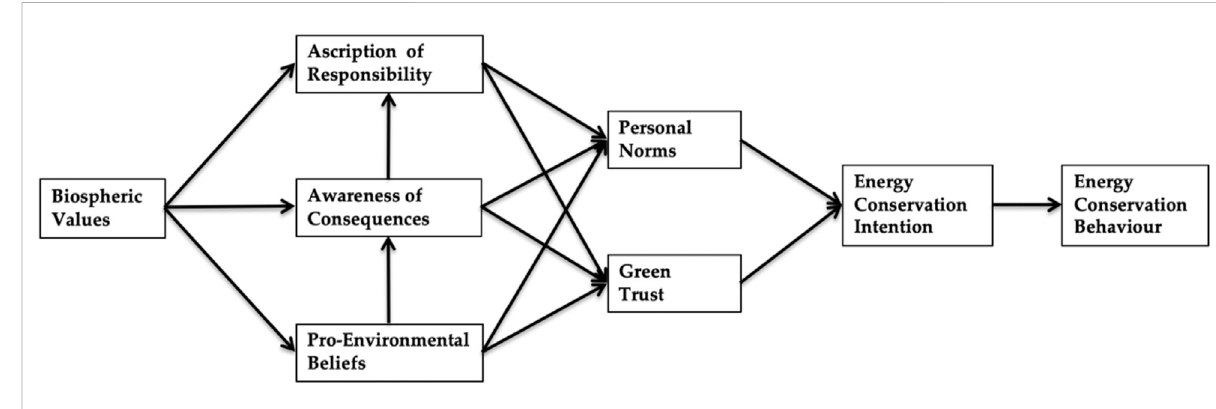
FIGURE 1 Research framework.